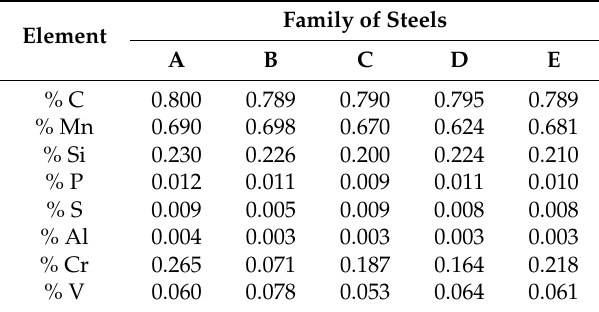
Table 1. Chemical composition of the five families of steels.